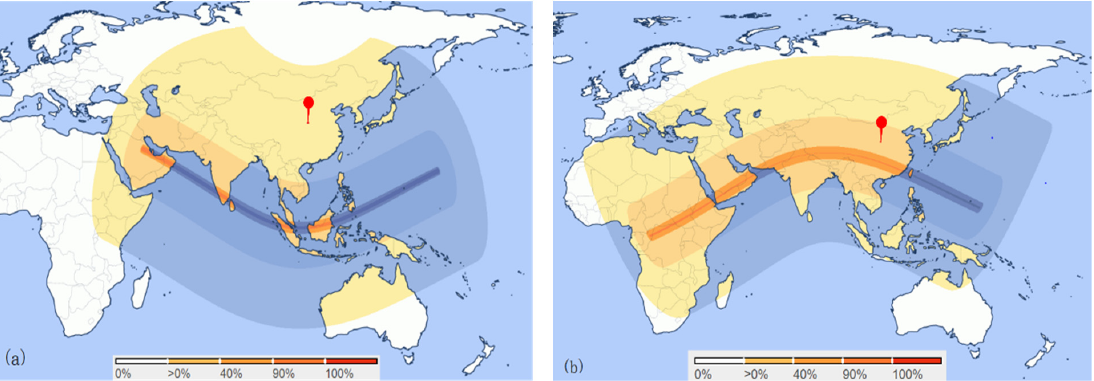
Figure 3. The portion of the sun covered by the moon (eclipse obscuration) and the red marker represents the observation site in Xi’an, China. ( a ) 26 December 2019, ( b ) 21 June 2020. Table 3. Stages and times of the eclipse events outlined for Xi’an (all times were local time, CST). Eclipse Time